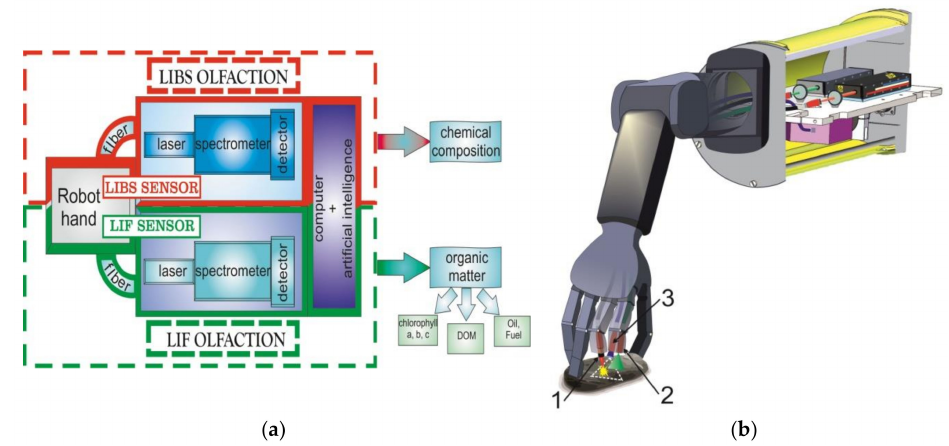
Figure 1. The concept of «”olfaction”; ( a ) Block scheme of “olfaction”; ( b ) Adjustment scheme of Laser Induced Fluorescence (LIF) and Laser Induced Breakdown Spectroscopy (LIBS) for the anthropomorphic complex. 1—laser radiation for LIBS; 2—laser radiation for LIF; 3—lens to focused radiation to spectrofluorometer.